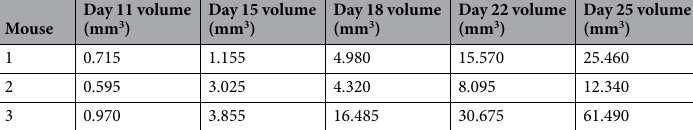
Table 1. Volumes of visible tumor on MRI of each mouse at each time